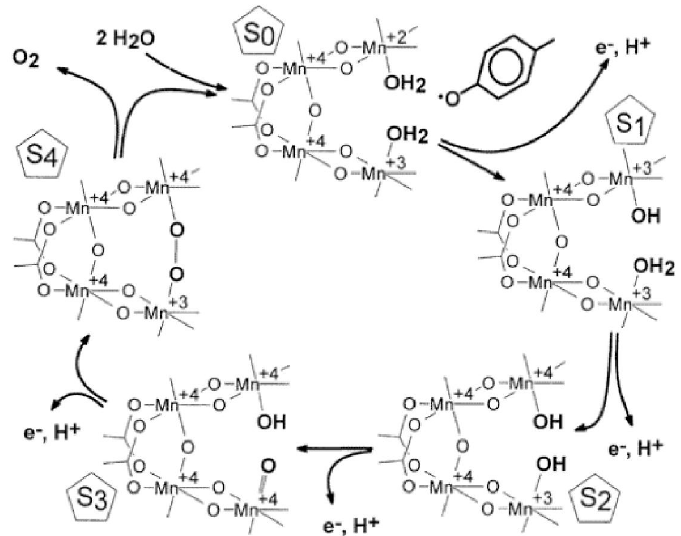
Figure 2. Proposed photosynthetic oxygen evolution mechanistic model (from [62], produced with permission from the American Association for the Advancement of